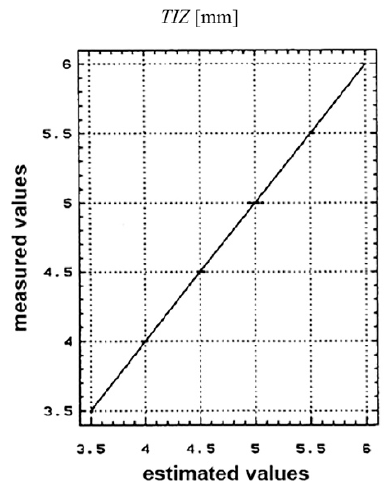
Figure 13. Thermal influenced zone values measured [mm].